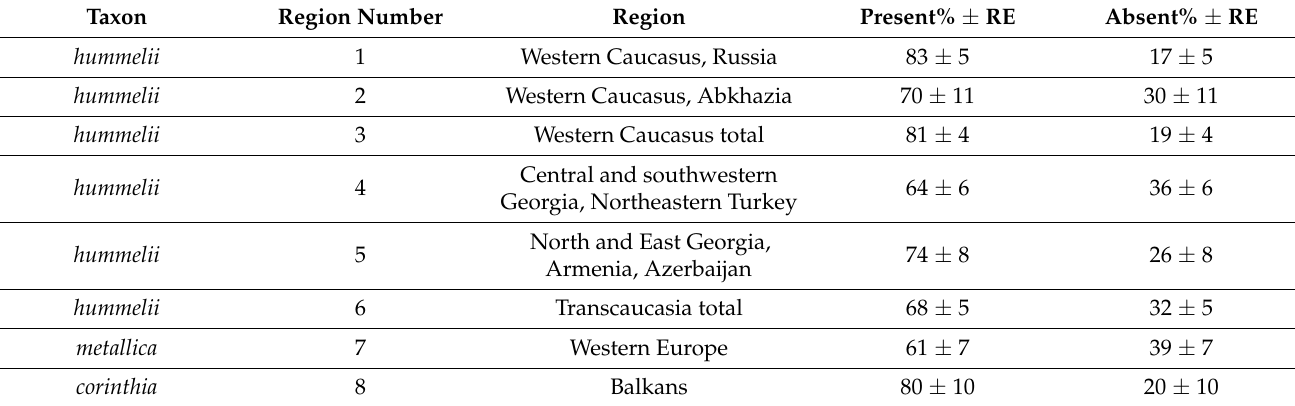
Table 7. Emargination of pronotal lateral side before base (present or absent). RE—share representativeness